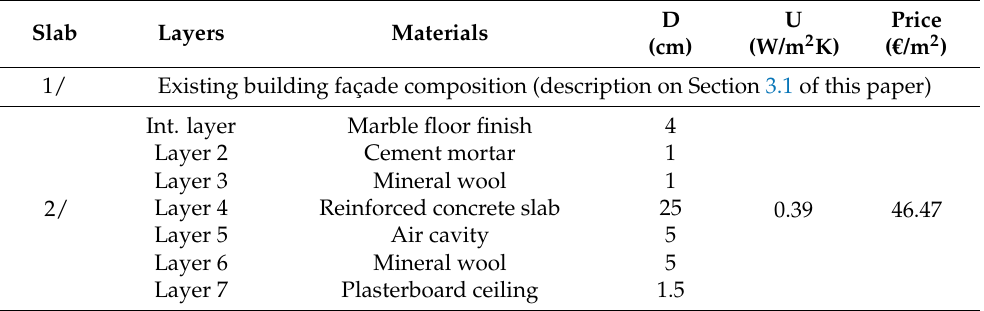
Table A5. Proposed renovation Measures for